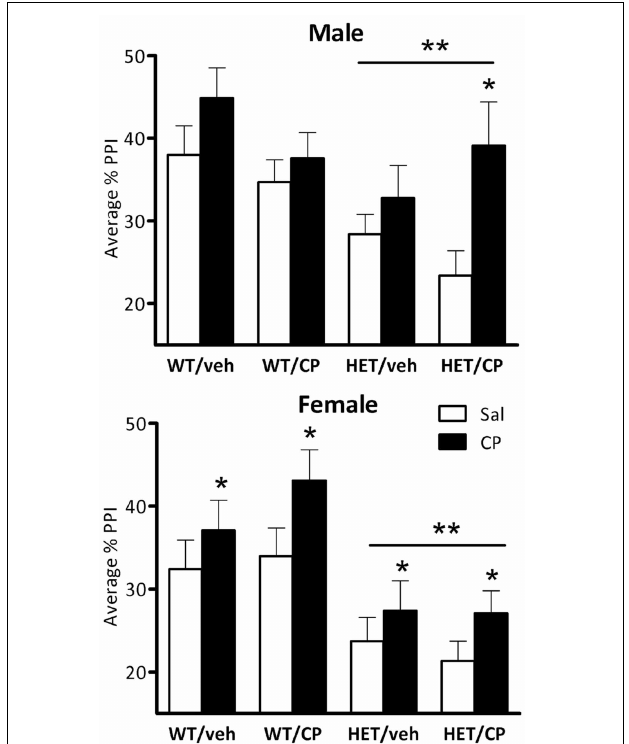
FIGURE 4 | Average percentage PPI in the four treatment groups: WT/veh, WT/CP, HET/veh, and HET/CP in both sexes. All groups were administered saline (Sal; open bars) and 0.4mg/kg CP55,940 (CP; black bars) before the PPI test. HET mice had significantly lower PPI after saline injection compared to wild-type controls. Acute CP treatment increased PPI in male “two hit” mice and in all female groups. ∗ P < 0 . 05 for difference with acute saline based on genotype × acute treatment interaction and post-hoc comparisons (males) or main ANOVA effect (females). ∗∗ P < 0 . 05 for difference between HET mice and wild-type controls based on ANOVA main